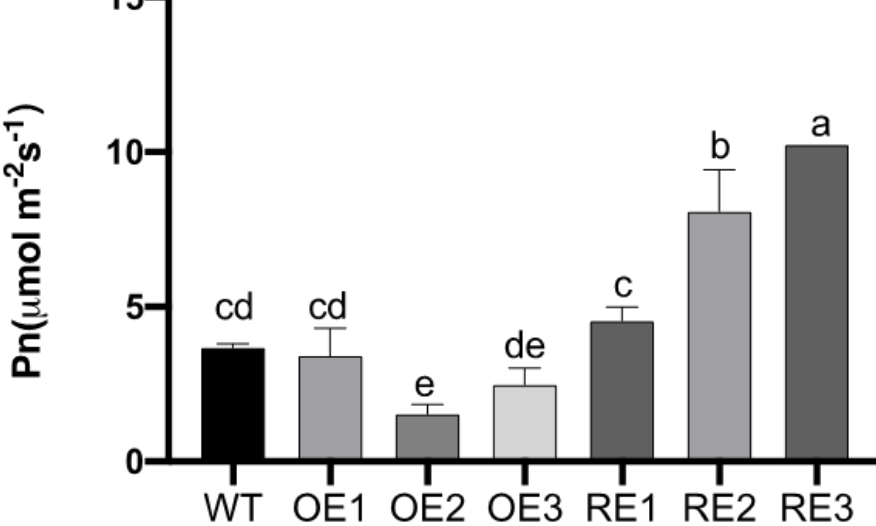
Figure 5. The difference of net photosynthesis rate among poplar transgenic and WT leaves under NaHCO 3 stress treatment. The means and standard errors were calculated with three replications ( p < 0.05). Multiple comparison was used via Duncan test. Different letters indicate significant